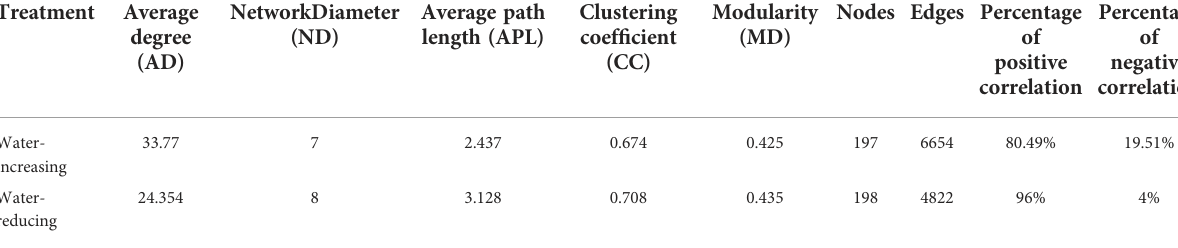
TABLE 4 Network properties of soil bacterial communities for water-increasing and water-reducing